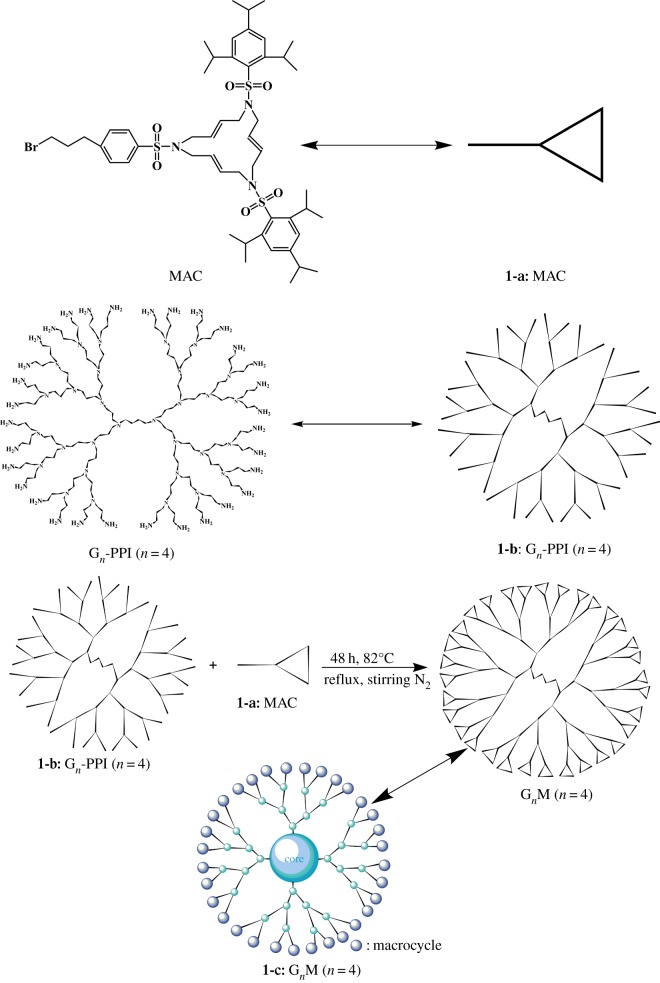
The synthesis route of GnM. MAC, Gn-PPI, and GnM are simplified as 1-a, 1-b and 1-c, respectively.